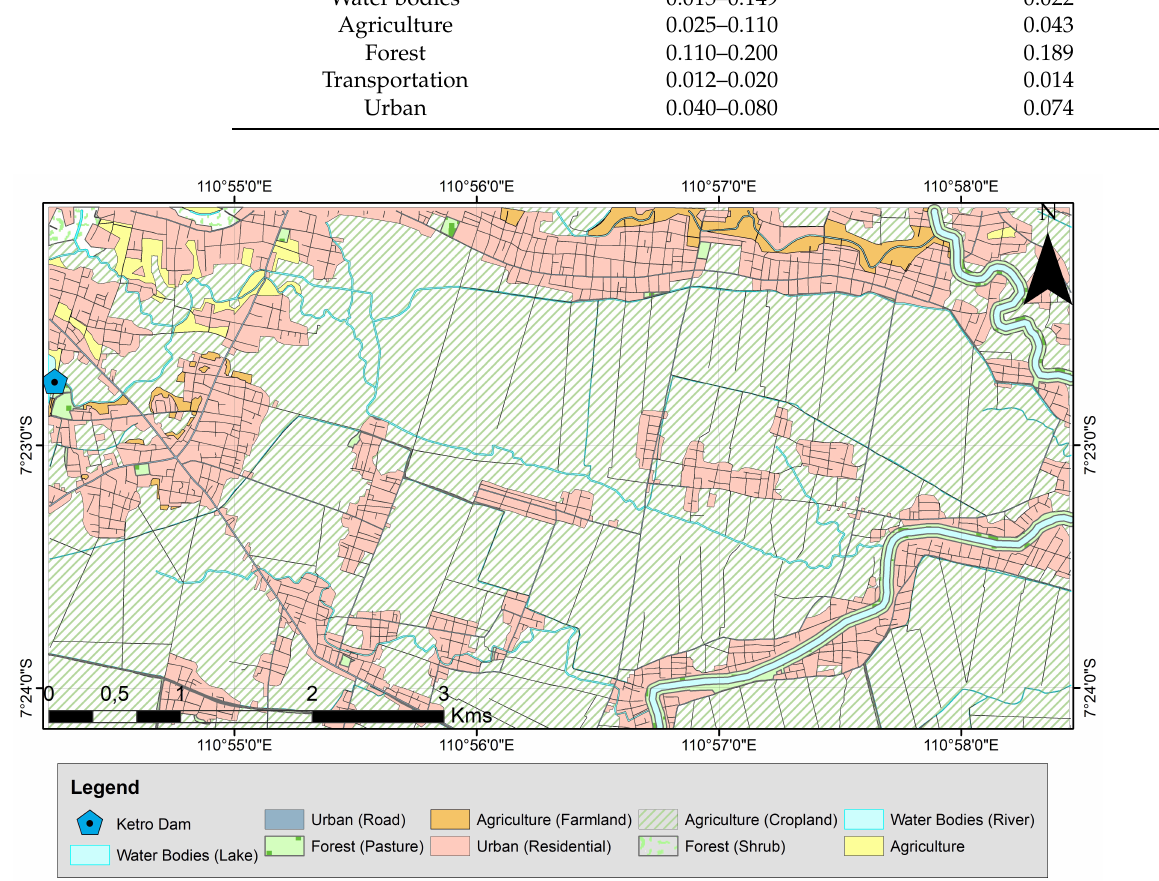
Figure 6. Land use map for the area downstream of Ketro